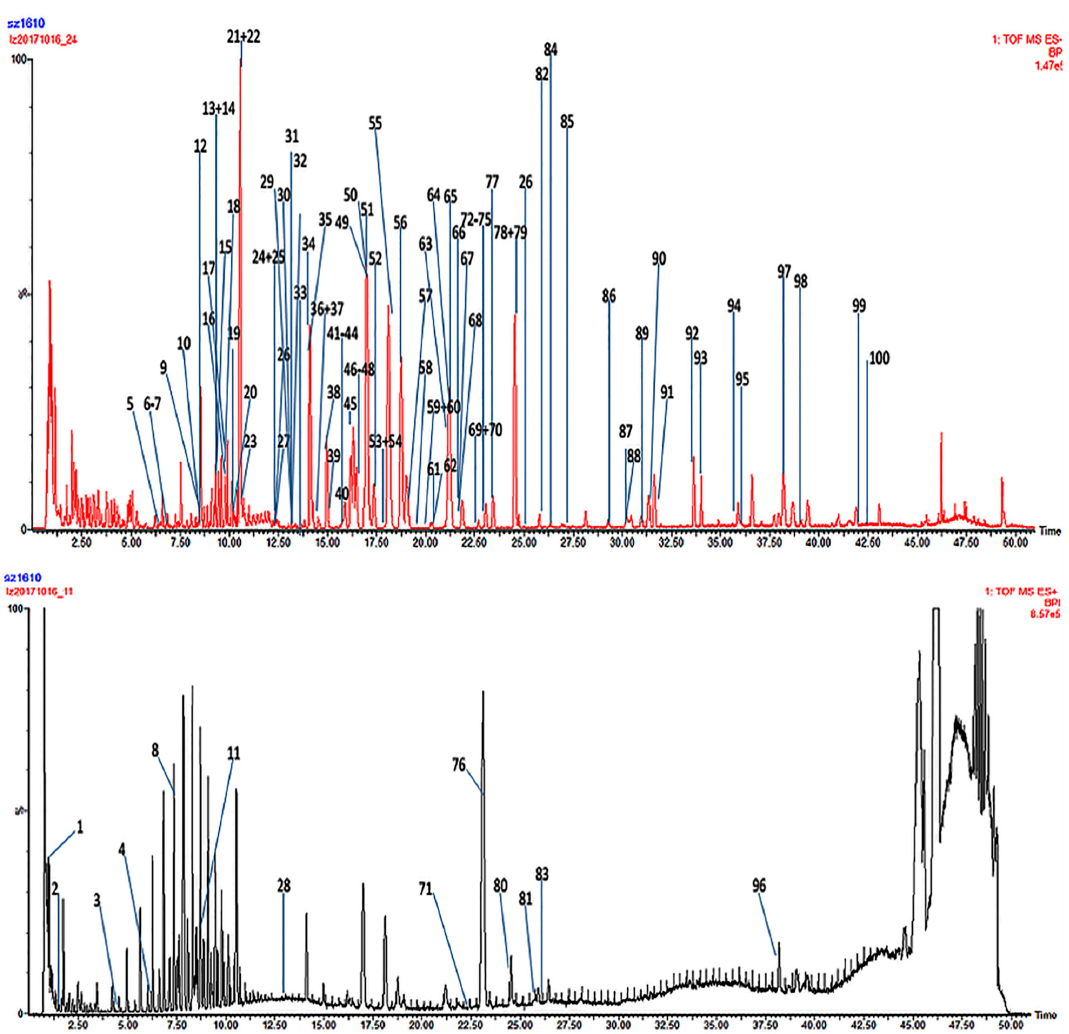
Figure 1. The representative based peak intensity (BPI) total ion chromatogram from a sample of Shengmai injection (SMI) based on ultra-performance liquid chromatography tandem quadrupole time-of-flight mass spectrometry (UPLC-QTOF-MS E ).